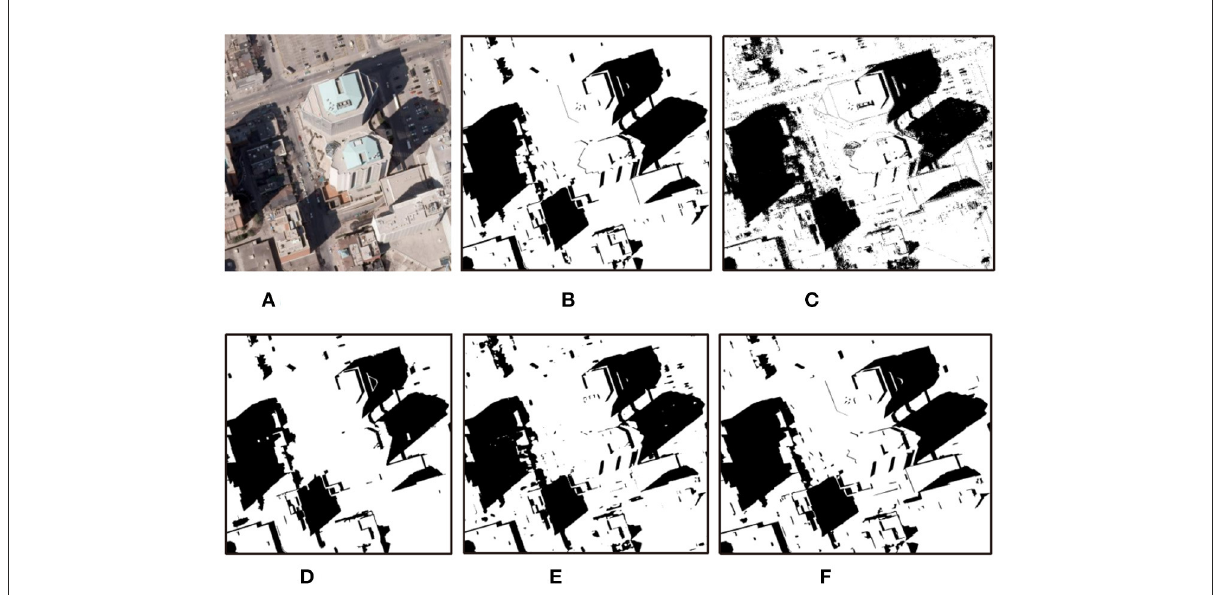
FIGURE11 Detection results with different methods on remote sensing images (Toronto). (A) Shadow image, (B) GT, (C) GSCA-Unet, (D) SAS, (E) DSAN, and (F) proposed.